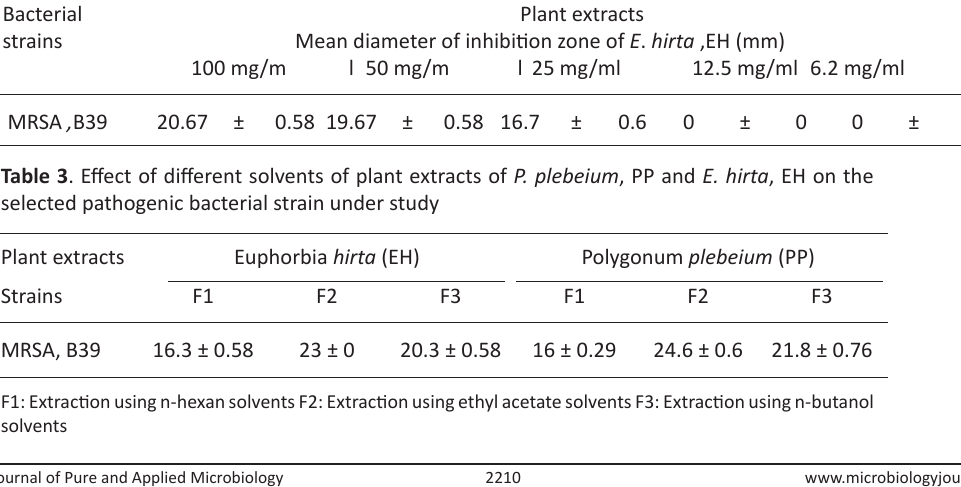
Table 2b. Determination of (MIC) of the plant extracts of E. hirta , EH against MRSA B39 Bacterial strains